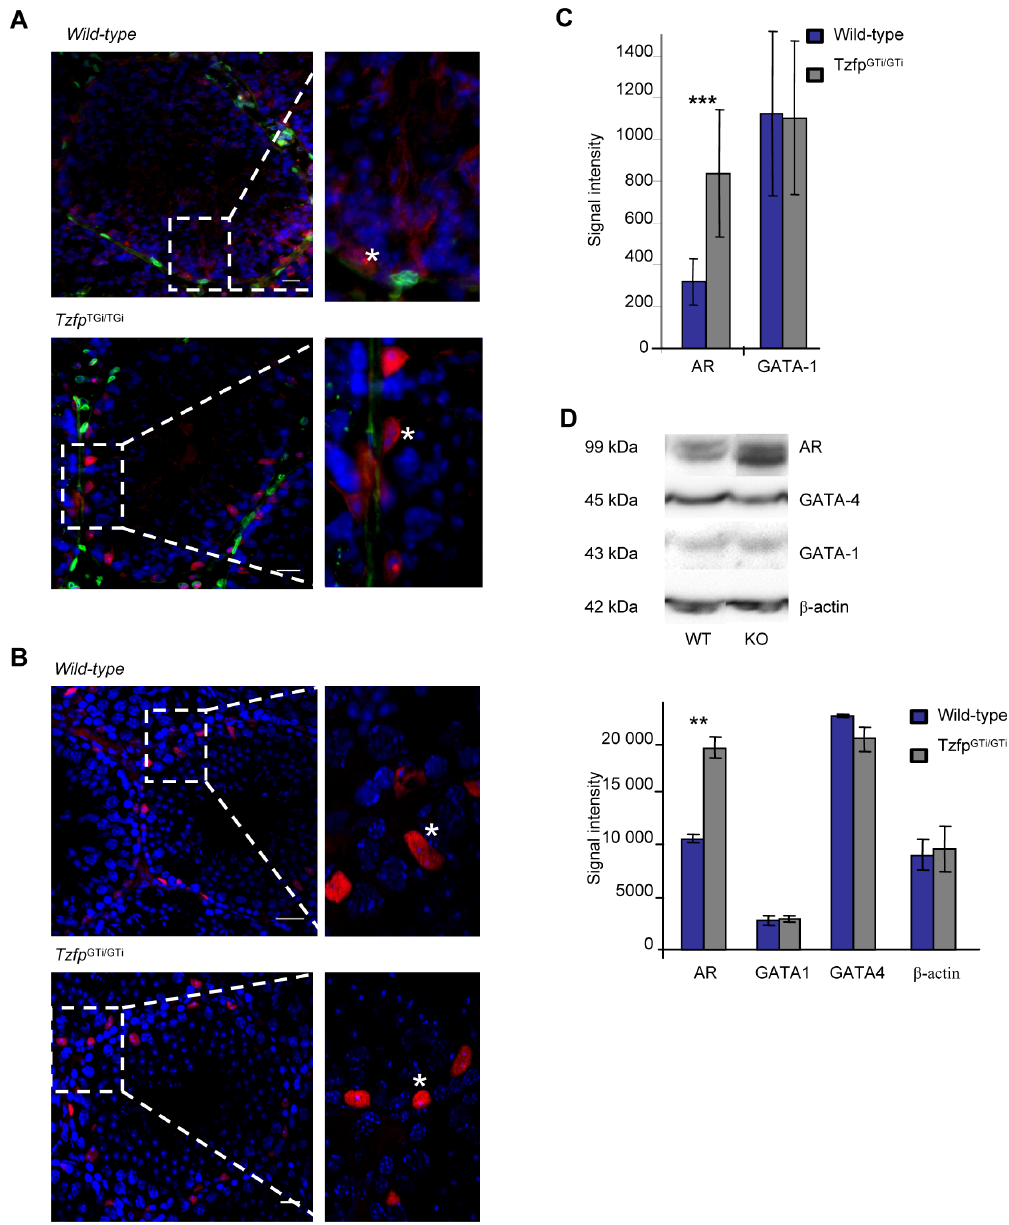
Figure 4. Expression of Androgen Receptor and GATA in wild-type and Tzfp GTi/GTi testis. Left panel showing sections of adult wild-type and Tzfp GTi/GTi testes incubated with anti-AR (A) and anti-GATA-1 (B) (both displayed in red). Anti-AR samples are co-stained with anti-laminin (green). The slides are counterstained with DAPI (blue). Star (*) in magnified area indicates Sertoli cell. Scale bar: 20 m m. C) Quantification of the antibody signal. Statistical analysis was performed using the two-tailed Student’s t test: *p , 0.05; **p , 0.01; ***p , 0.001. D) Western blot analysis showing the presence of Androgen Receptor, GATA-1 and GATA-4 in adult wild-type and Tzfp GTi/GTi testes. b -actin is used as a loading control. doi:10.1371/journal.pone.0062314.g004 sites of GATA expression, with detectable levels of GATA-1, 2, 4 and 6 [49,50]. Of these factors, only GATA-2 is expressed in the germ-cells [49], whereas Sertoli cells express GATA-1, 4 and 6. As described above, Tzfp is known to be a repressor of GATA, and an interaction between TZFP and the GATA factors 2 and 3 have been shown [13,51]. However, all vertebrate GATA proteins share a conserved DNA and protein-binding domain composed of two zinc fingers [52]. This leads to an apparent redundancy in binding properties to target sequences, indicating that other GATA members might also bind TZFP.